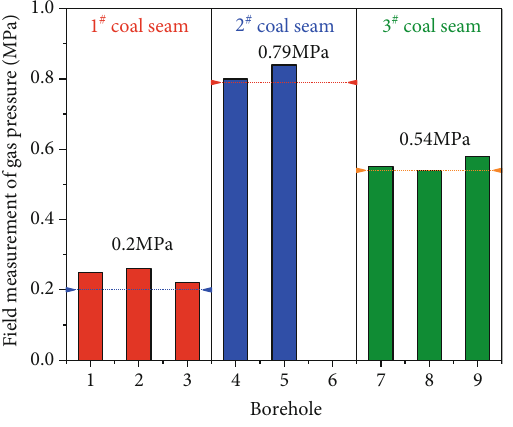
Figure 12: Comparison between new method and indirect